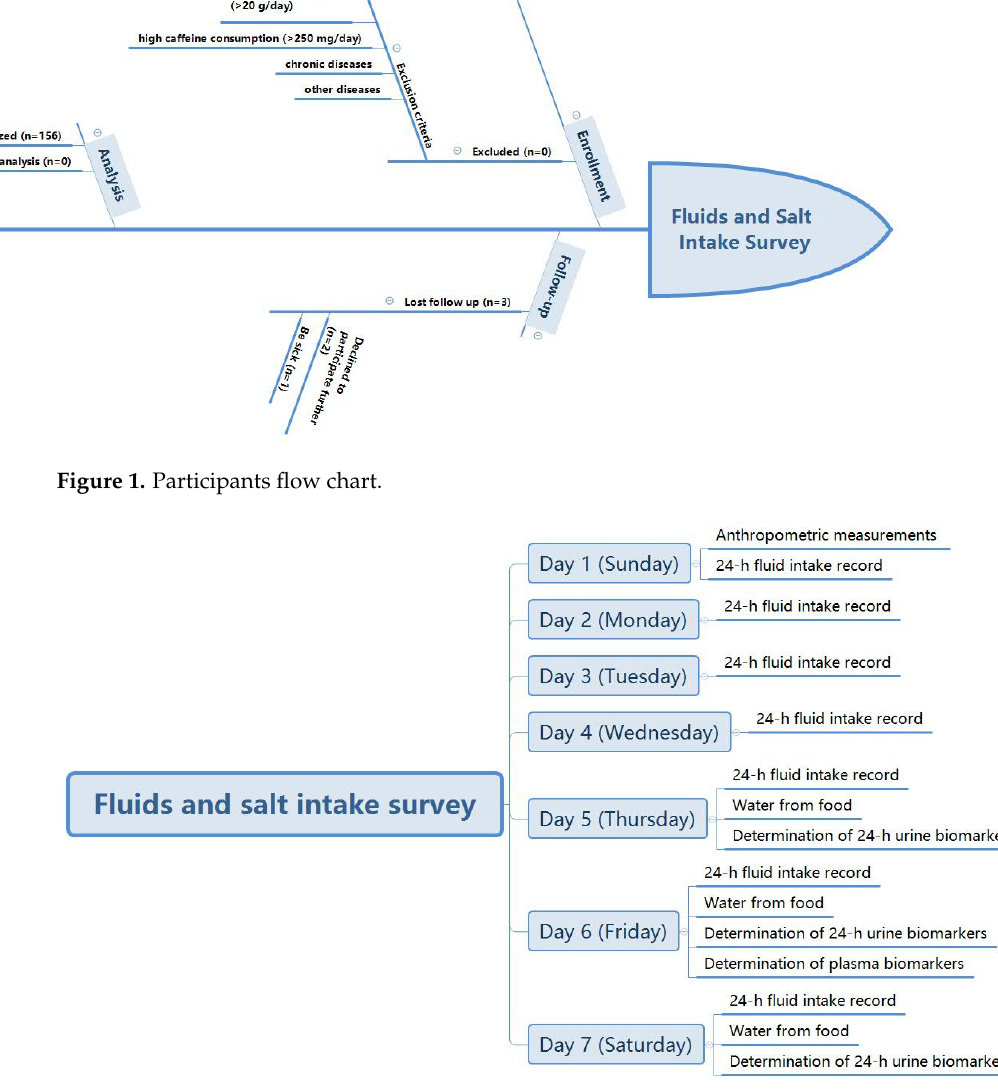
Figure 2. The study procedure.